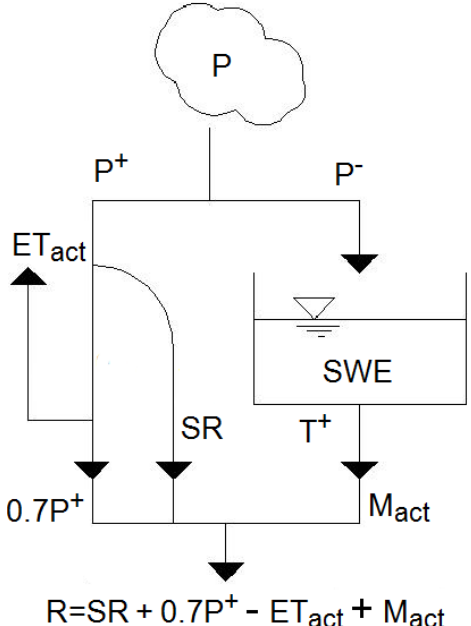
Fig. 1. Qualitative representation of the structure of the water bal- ance model. P is the input to the system, divided into liquid ( P + ) and solid ( P − ) precipitation. SWE is the snow water equivalent contained in the snow storage; T + ( T − ) represents positive (neg- ative) temperature; SR is the storm runoff; M act is the snowmelt; ET act the actual evapotranspiration and R the